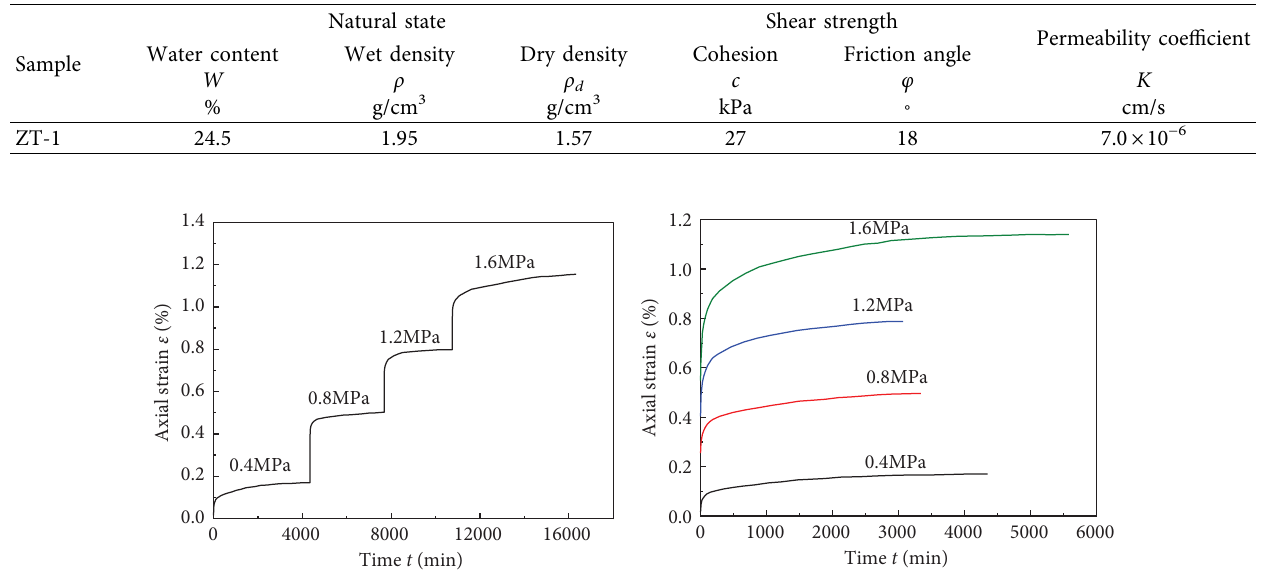
Table 1: Rock mechanics parameters.